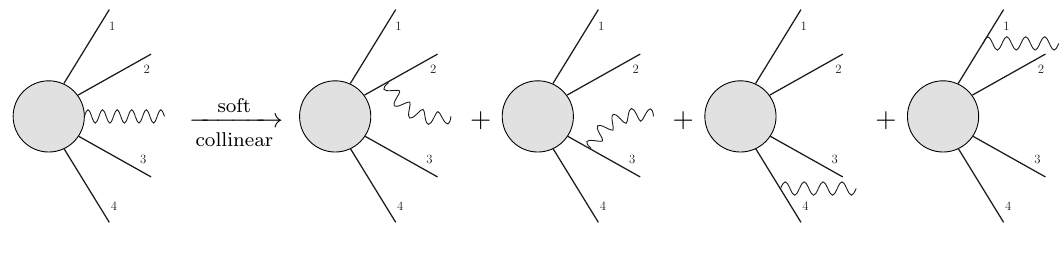
Figure 2 . Factorization of soft or collinear photon emission in